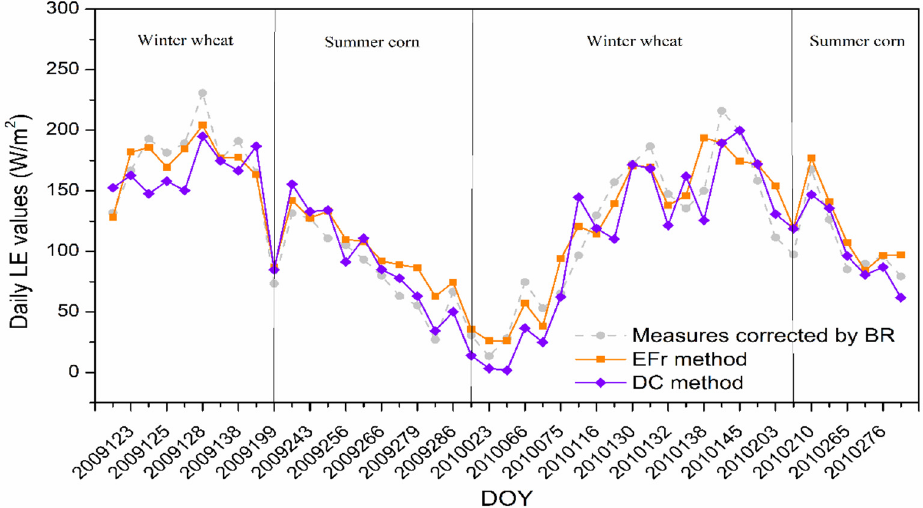
Figure 9. Temporal variations in daily ET calculated directly by the DC method and temporal upscaled by the EFr method against with ET measurements corrected by the BR scheme, during different crop (winter wheat and summer corn) growth stages.